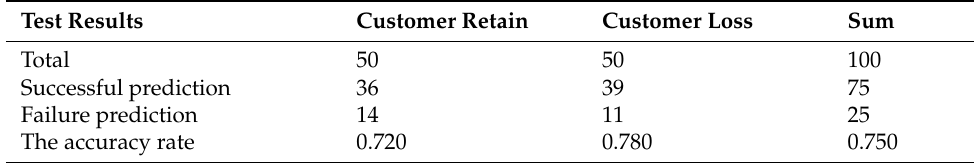
Table 20. Discriminant result checklist—adapted from Zhang